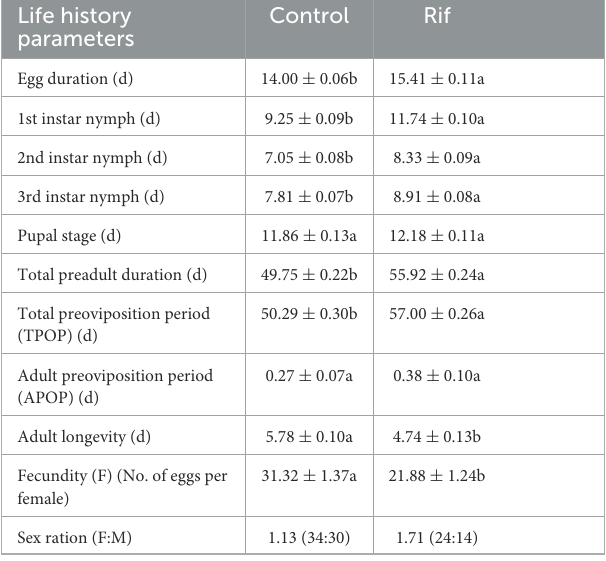
TABLE 4 Stages and developmental periods (days) (mean ± SE) of A. camelliae from the rifampicin treatment and control group. Life history